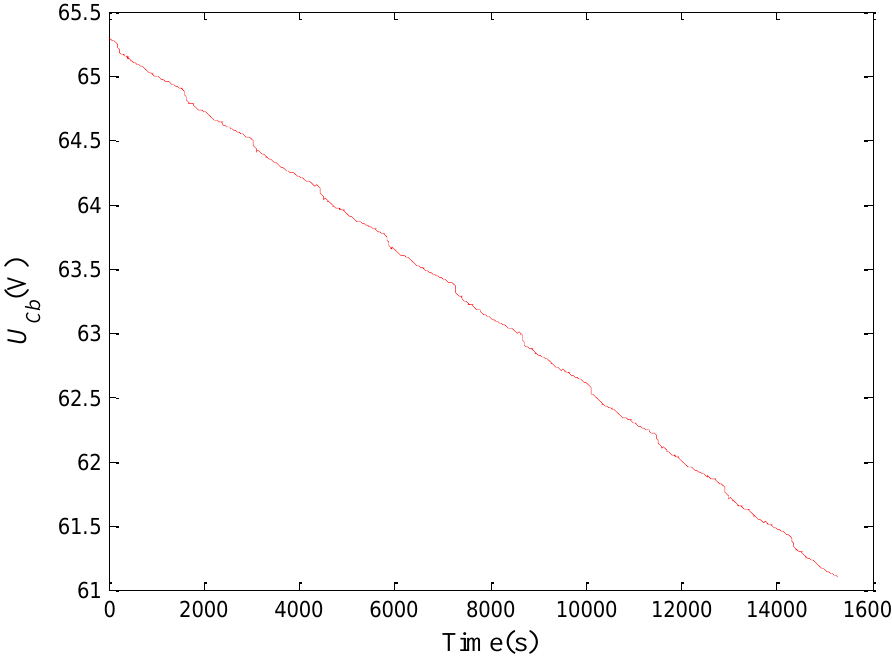
Figure 17. Estimation of the voltage of the bulk